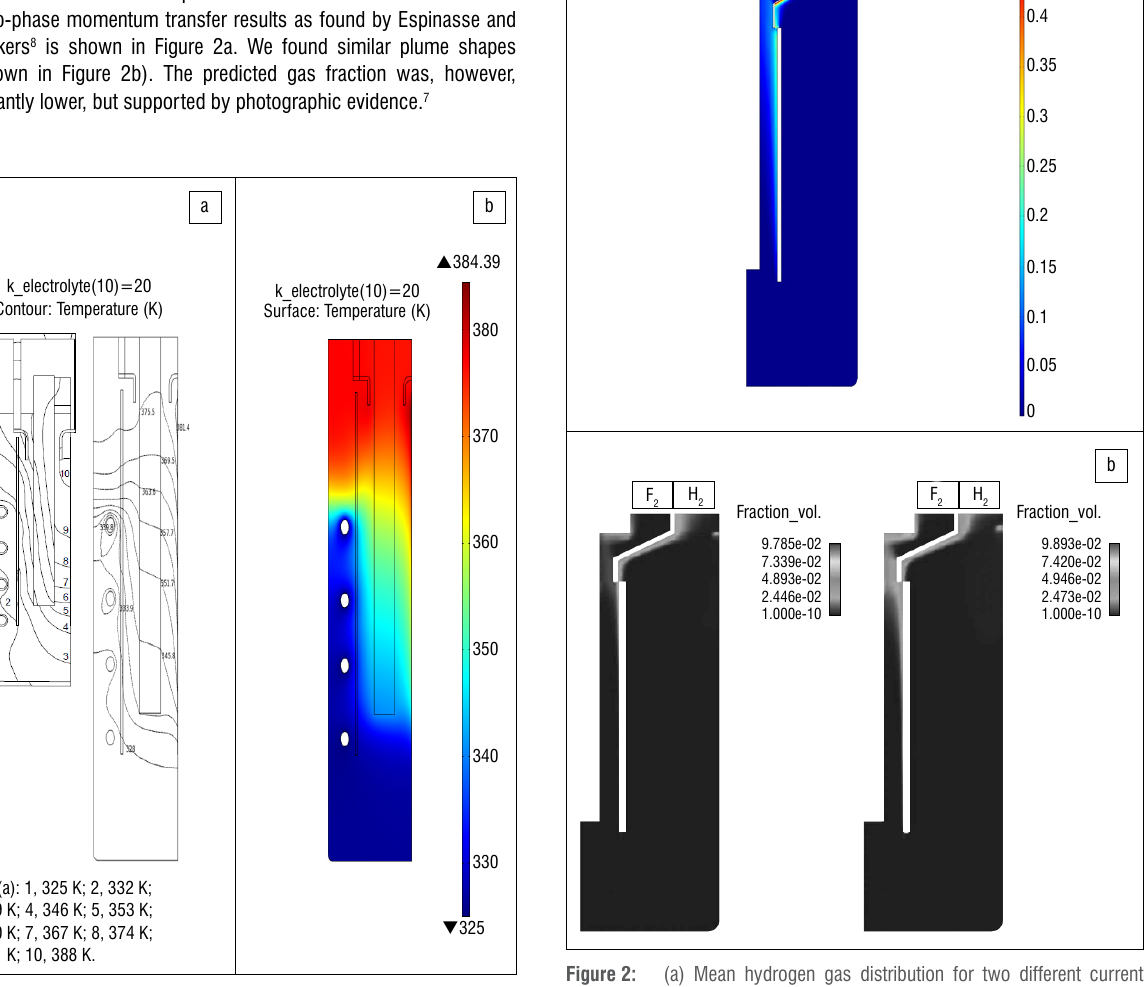
Figure 1: (a) Temperature profile within the electrolyser as simulated 1 and redrawn for this publication. (b) Temperature profiles (K) inside the reactor as simulated in this study.